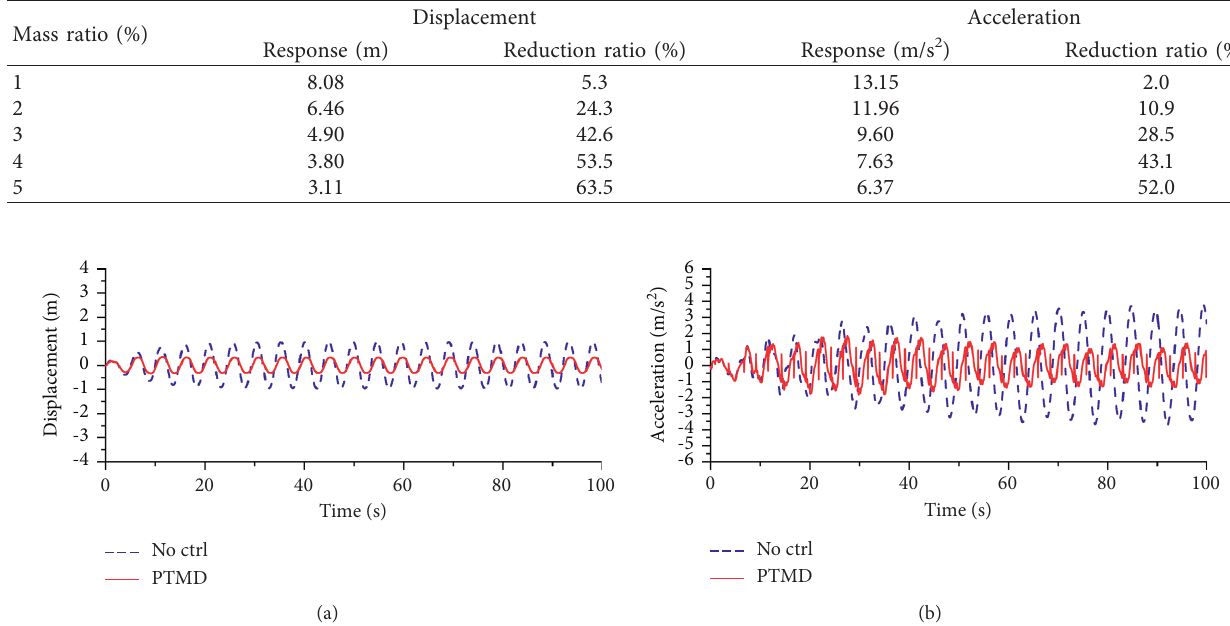
Figure 8: : Maximum response of the SCR under OC2: (a) displacement and (b)